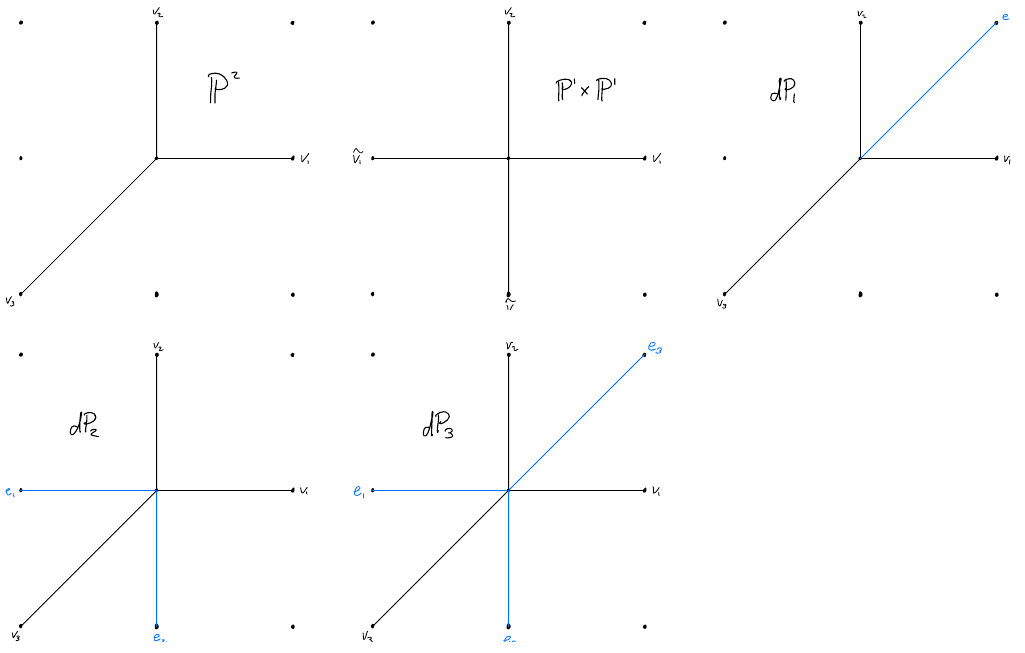
Figure 6 . The fans of the toric del Pezzo surfaces. The blue edges are associated with toric coordinates e i s.t. the locus e i = 0 corresponds to the exceptional divisor E i